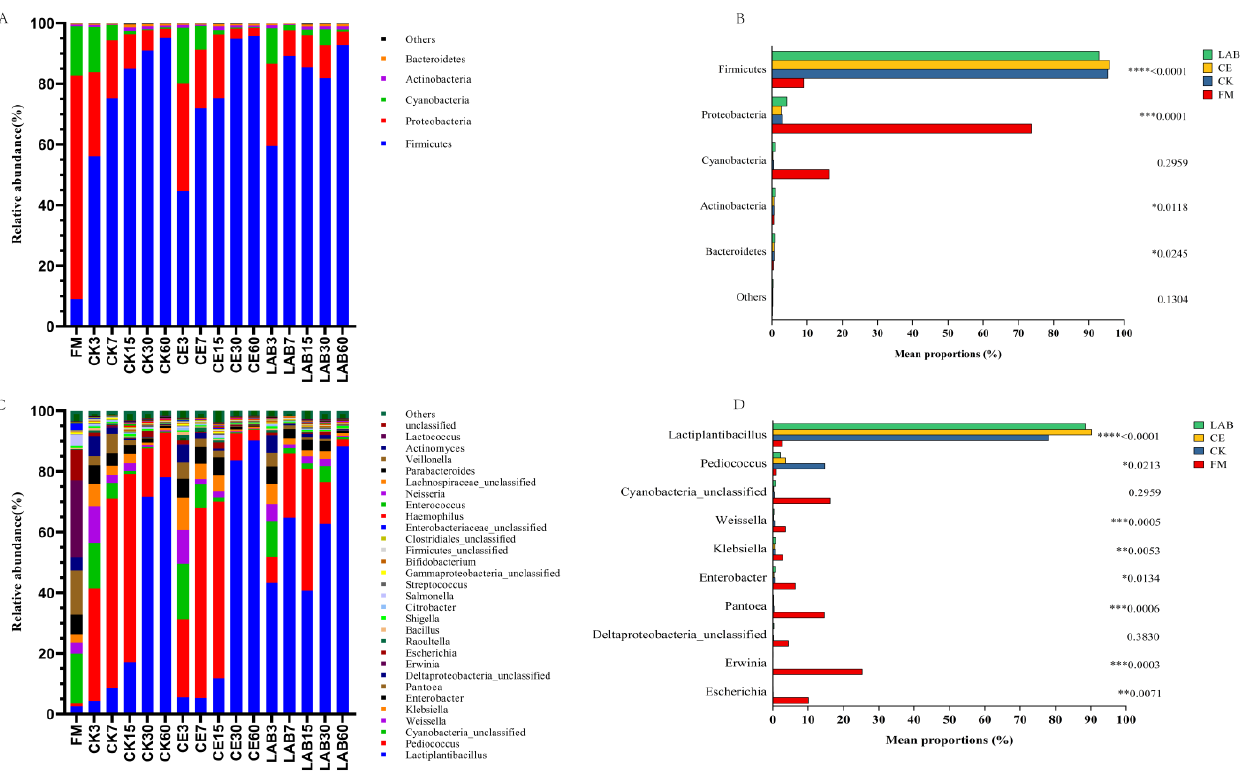
Figure 2. The bacterial community of FM and silage samples. ( A ) The bacterial community was shown at the phylum level. ( B ) One‑way analysis of variance bar plots of the phylum level (10 most abundant phylum) among Caragana korshinskii silage groups after 60 days of ensiling. ( C ) The bac‑ terial community was shown at the genus level. ( D ) One‑way analysis of variance bar plots of the genus level (10 most abundant genera) among Caragana korshinskii silage groups after 60 days of ensiling. *, p < 0.05; **, p < 0.01; ***, p < 0.001; ****, p < 0.0001; FM, fresh material; CK, no additive control; CE, cellulase; LAB, lactic acid bacteria.